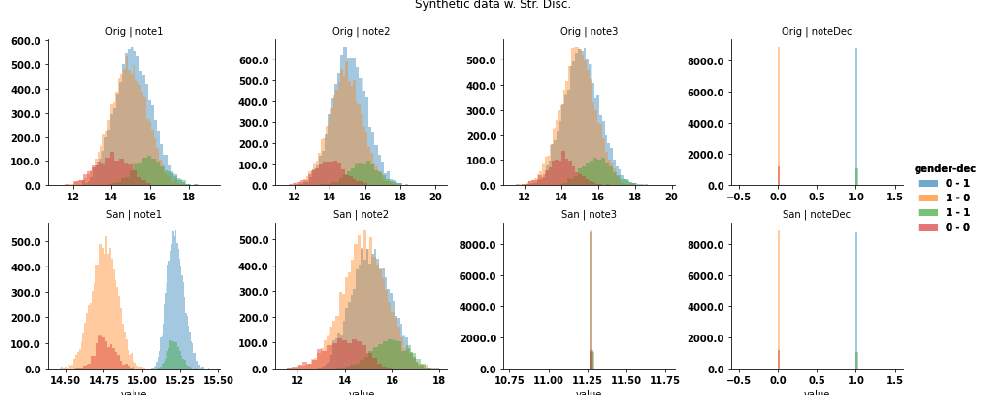
Figure 16. Distribution of attributes on a synthetic dataset with stronger discrimination. The sanitization (bottom) starts with the alignment of some distributions ( note 1 ) to match the decision criteria ( noteDec ), which is left untouched.